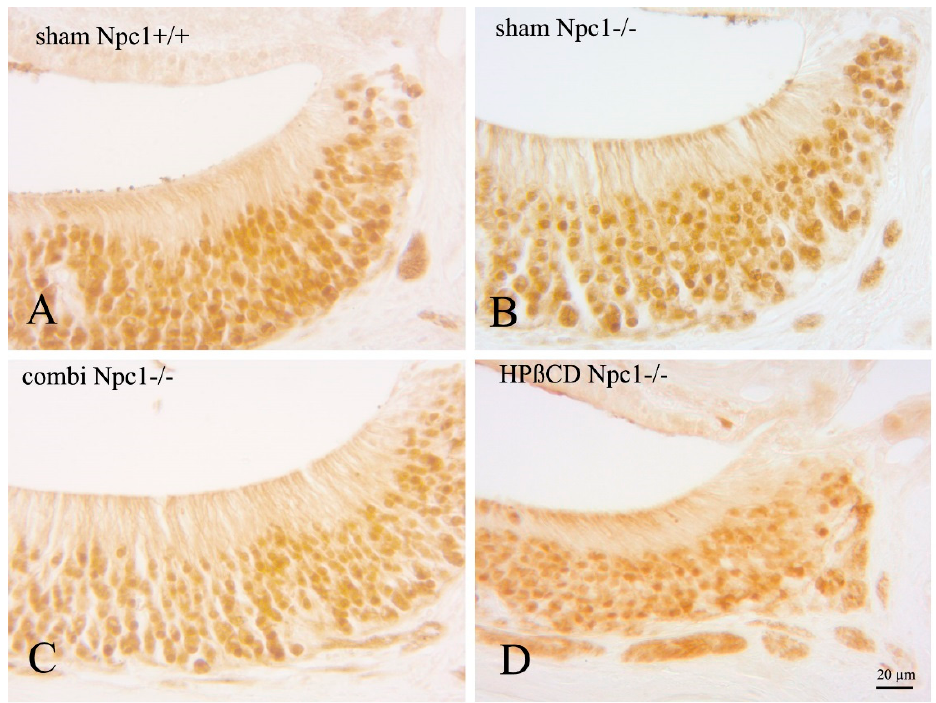
Figure 6. Detailed images of OMP immunoreactivity (IR) of vomeronasal epithelial cells in Npc1 +/+ ( A ) and Npc1 − / − mice ( B – D ). Intensities and distribution of OMP-IR do not apparently differ within the groups.